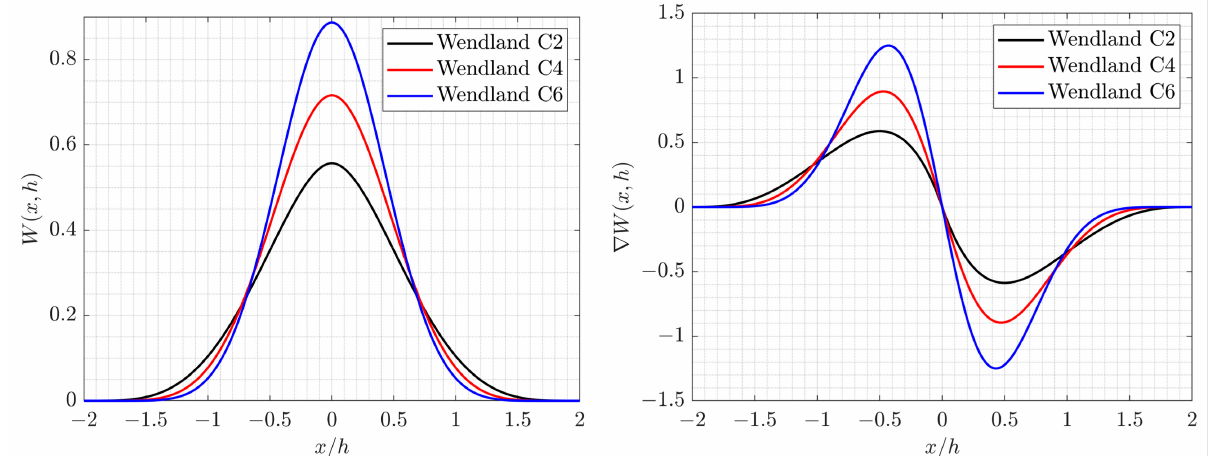
Figure 1. ( left ) Different Wendland kernels used in the study. ( right ) Derivatives of the kernel